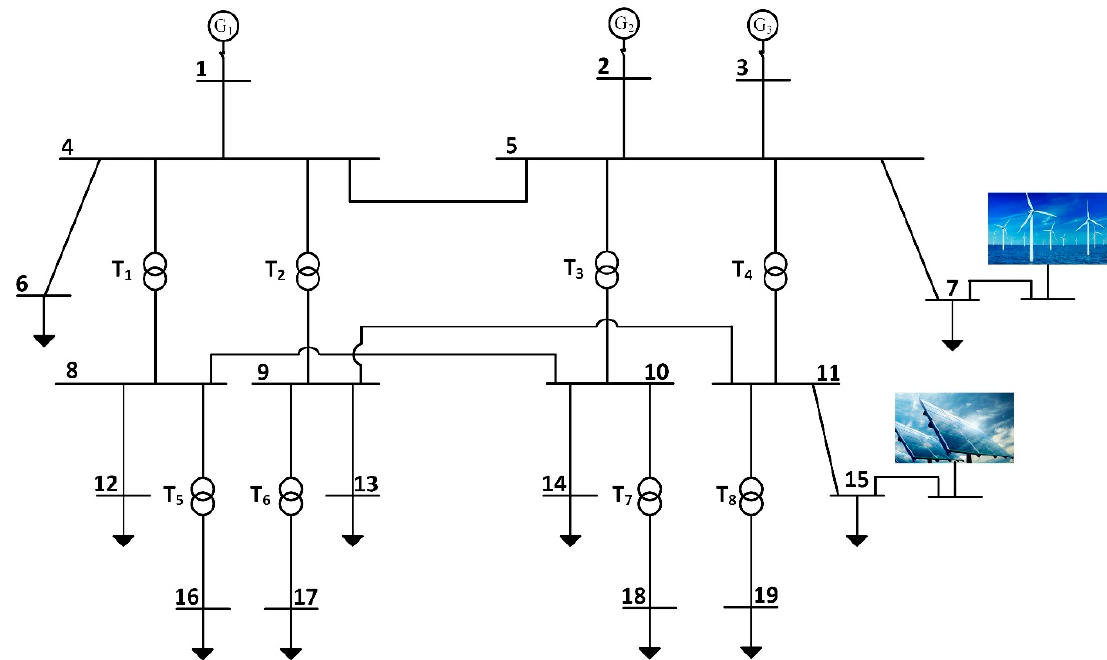
Figure 3. Structure diagram of offshore platform power system integrated with new energy.